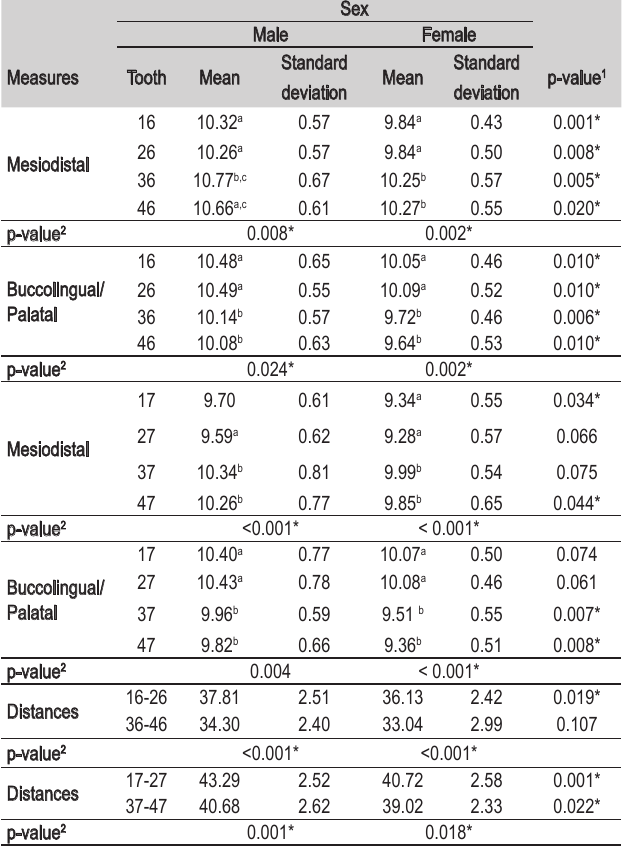
Table 1 - Mean and standard deviation of the measurements according to tooth and sex. Dental nomenclature follows the system proposed by the Federacion International Dental (FDI). João Pessoa, PB, Brazil,